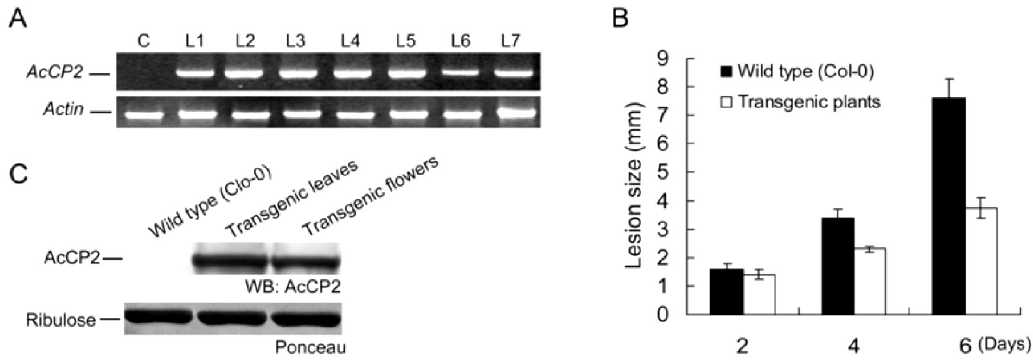
Figure 4. Disease resistance to fungal pathogen in transgenic Arabidopsis plants overexpressing AcCP2 . ( A ) Detection of transgenic Arabidopsis plants using RT-PCR. Actin was used as an internal control; ( B ) Disease degree was showed on the leaves of wild-type (Col-0) and transgenic Arabidopsis plants 2, 4 and 6 days after inoculation; and ( C ) Western blotting analysis for AcCP2 protein in transgenic Arabidopsis plants. Ribulose is used as a